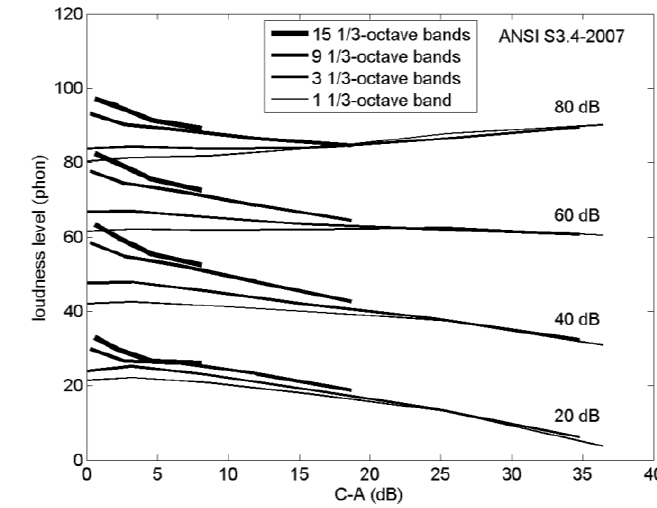
Figure 7. Loudness level as a function of C–A, calculated with ANSI S3.4-2007 for the spectra shown in Figure 6, for A-weighted sound levels of 20, 40, 60, and 80 dB, and center frequencies of 31, 63, 125, 250, 500, and 1000 Hz (see the